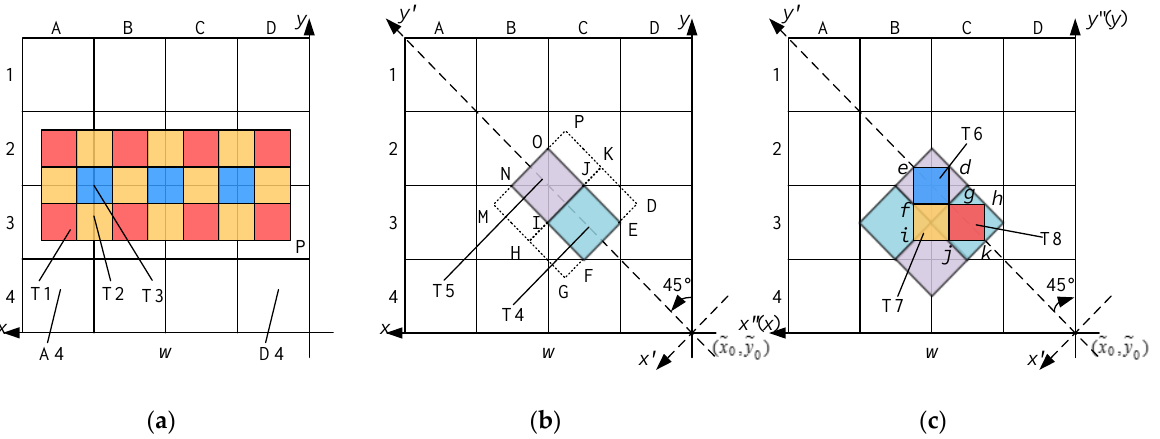
Figure 4. The photoelectric intensity distribution curve.